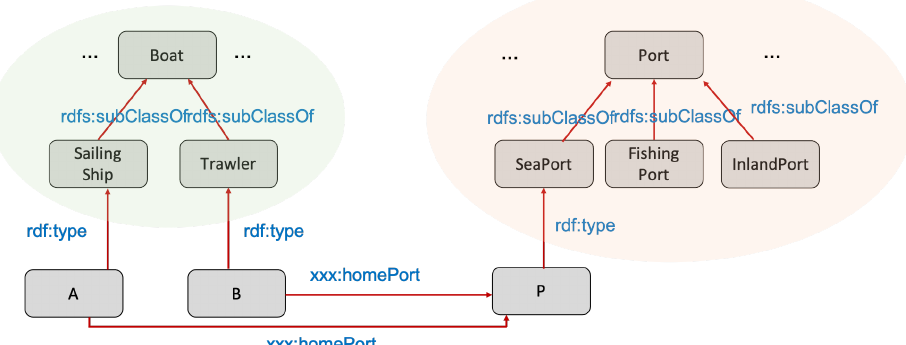
Figure 4. A K-graph representing knowledge about a sailing ship A and a trawler B sharing the same home port P . Through the predicate rdf:type , two ontologies, available in the LOD Cloud and describing a universe of boats and ports, respectively, are referred